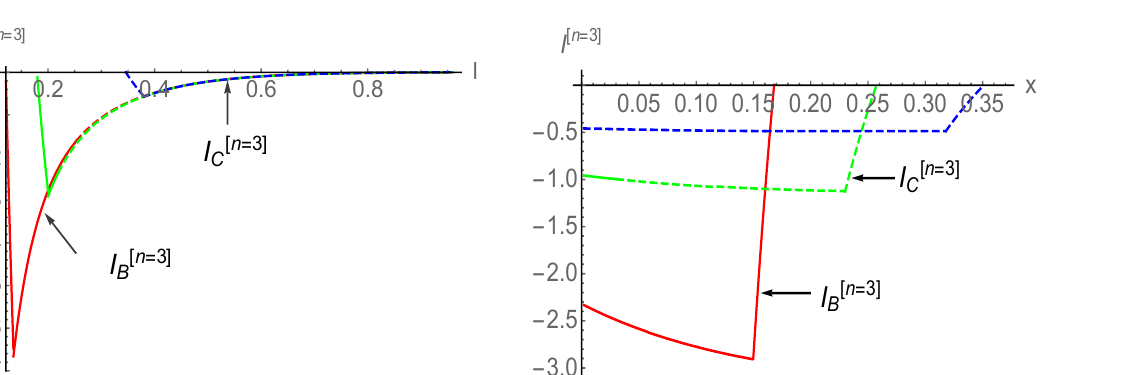
Figure 12 . I [ n =3] for S B and S C phases as a function of strip length ‘ . The solid lines corre- spond to I [ n =3] whereas the dashed lines corre- B sponds to I [ n =3] . The red, green and blue lines C correspond to separation length x = 0 : 10, 0 : 15 and 0 : 30 respectively. In units GeV.